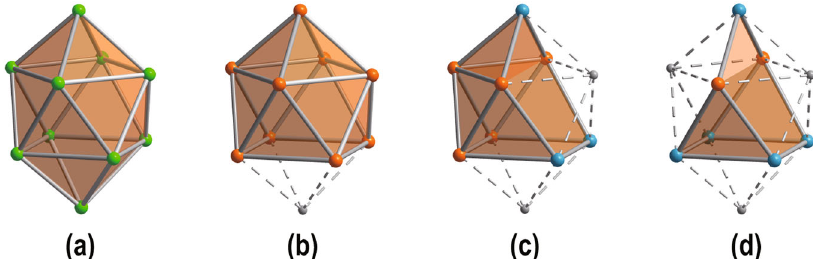
Fig. 1 Four representative structures from closo to hypho -type (this work). a [B 10 H 10 ] 2 − , b [E 9 ] 4 − (E = Si-Pb), c [Sn 5 Sb 3 ] 3 − , d hypho -[Sn 2 Sb 5 ] 3 − . The globe colors are as follow: B = green, Tt (Si-Pb) = orange, Sb =